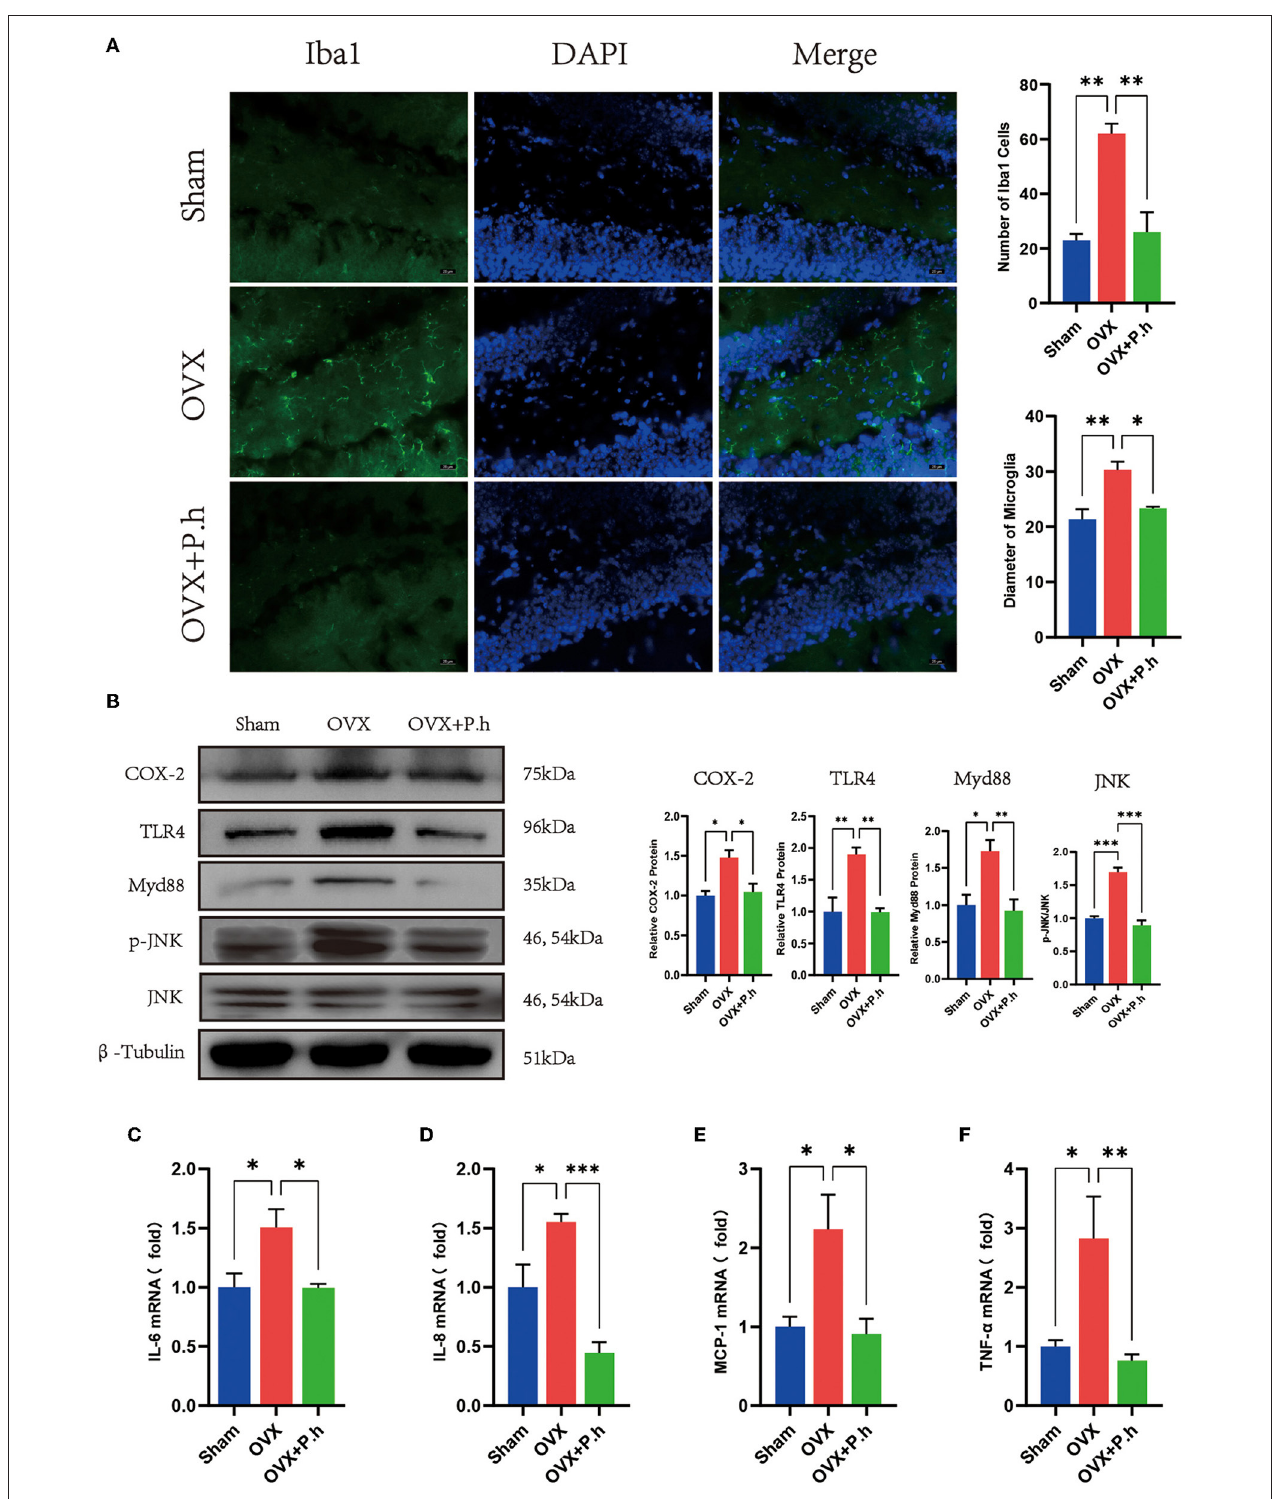
FIGURE 6 | P. histicola inhibited the hippocampal inflammation in OVX mice. (A) Immunofluorescence of microglia marker Iba1 of DG area and the quantification of the number and size of Iba1 positive cells. Magnification 400 × . Scale bar = 20 µ m. (B) The ratio of COX-2, TLR4, Myd88 to β -tubulin and p-JNK to JNK in hippocampus. (C) IL-6 mRNA level in hippocampus. (D) IL-8 mRNA level in hippocampus. (E) MCP-1 mRNA level in hippocampus. (F) TNF- α mRNA level in hippocampus. Data are presented as means ± SEM ( n = 3–4/group). * p < 0.05, ** p < 0.01, *** p < 0.001.